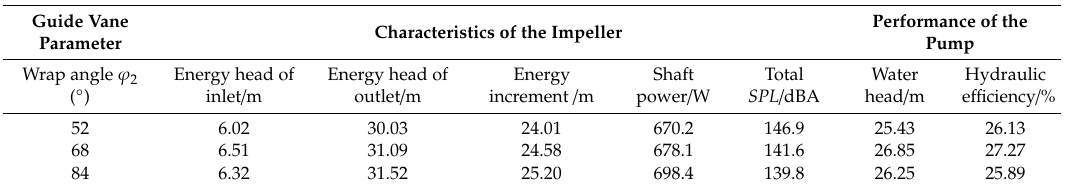
Table 7. Correlations between the wrap angle of the positive guide vane and the hydraulic and hydroacoustic characteristics of the impeller.